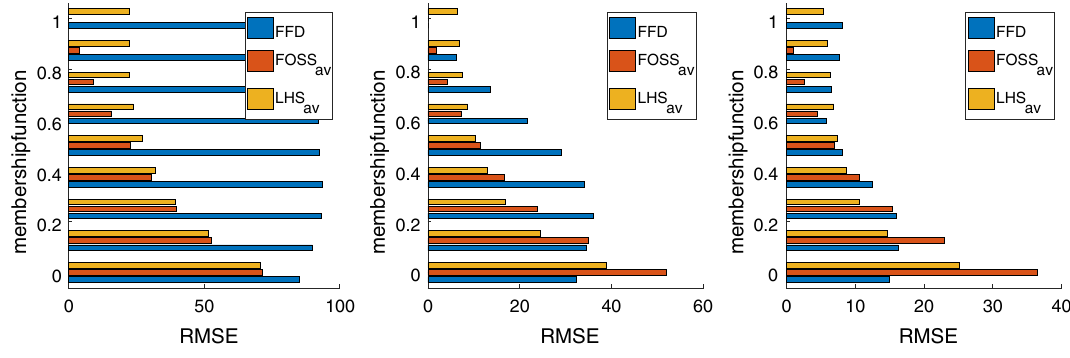
Fig. 14 Branin function: average RMSE on 𝛼 -cuts for a RBF surrogate with 4 (left), 9 (center), and 16 (right) sampling